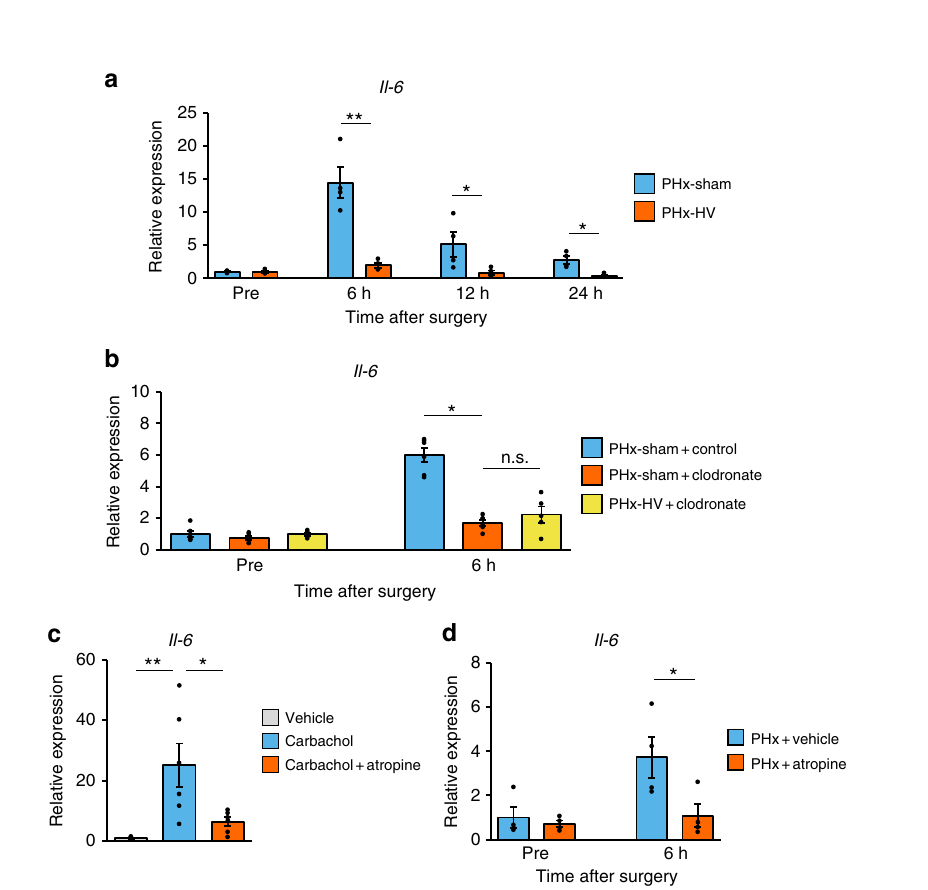
Fig. 6 Vagal signals increase macrophage IL-6 production after PHx. a Relative gene expressions of Il-6 after surgery in PHx-sham mice ( n = 4 per group) and PHx-HV mice ( n = 4 per group). b Relative gene expressions of Il-6 after PHx-sham in control liposome-treated ( n = 5 – 6 per group) and clodronate liposome-treated mice ( n = 5 – 6 per group), and after PHx-HV in clodronate liposome-treated mice ( n = 5 – 6 per group). c Relative gene expression of Il-6 in primary macrophages after 4 h of stimulation with vehicle ( n = 6), 100 µ M carbachol ( n = 6), or both 100 µ M carbachol and 100 µ M atropine ( n = 6). d Relative gene expressions of Il-6 after PHx in vehicle-treated ( n = 4 per group) and atropine-treated ( n = 4 per group) mice. * P < 0.05; ** P < 0.01 assessed by unpaired t test ( a and d ), or assessed by one-way ANOVA followed by Bonferroni ’ s post hoc test ( b and c ). n.s., not signi fi